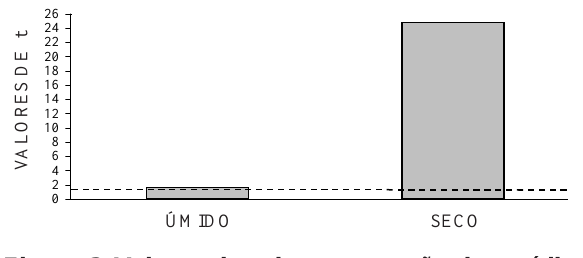
Figura 2. Valores de t da comparação das médias dos valores de resistência à penetração (horizonte coeso menos não-coeso), em dois níveis de umidade. A linha tracejada representa o valor de t tabelado (p = 5%). Valores acima da linha tracejada indicam diferença significativa a